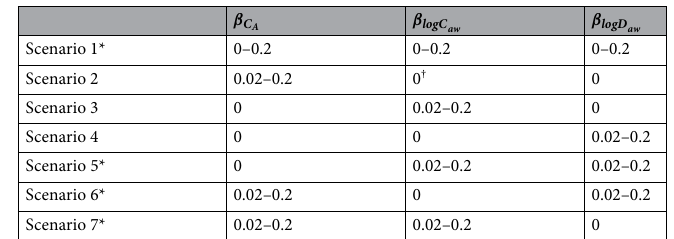
Table 1. Seven scenarios considered in the simulation study, where the relation of X to each NO parameter ( β C , β logC , β logD ) varied from 0 to 0.2, with a step size of 0.02. *In Scenarios 1 and 5–7, the non-zero β A aw aw values are identical (e.g., the first three settings of Scenario 1 have β C